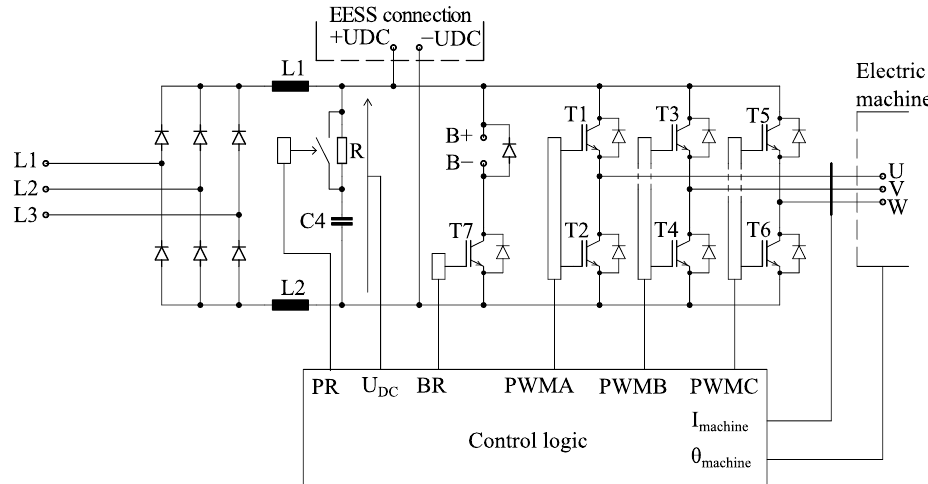
Figure 4. Schematic of the elevator VFD.